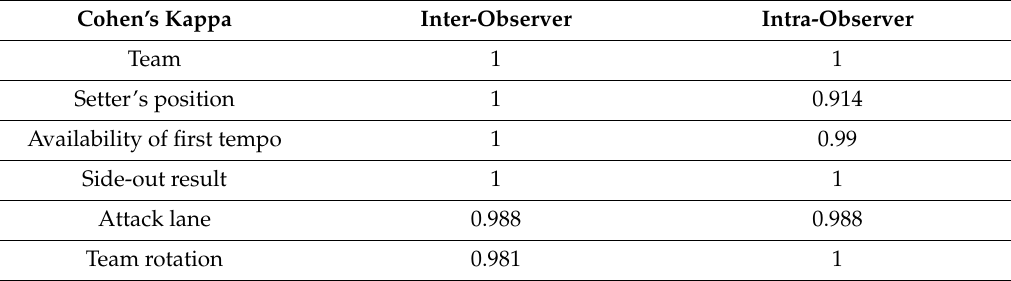
Table 1. Inter-observer and intra-observer